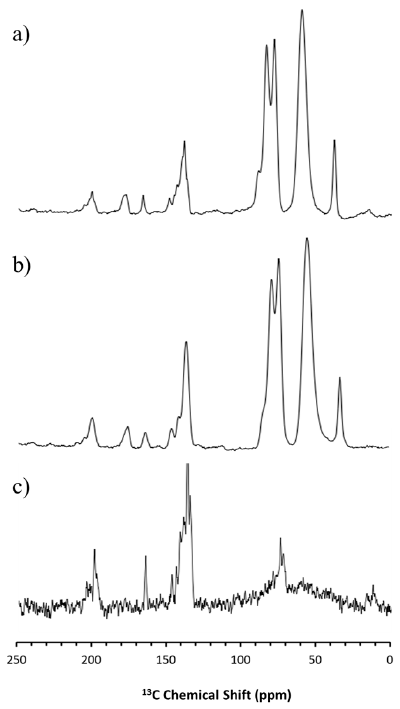
Figure 7. 13 C SS-NMR spectra for crystalline carbamazepine ( c ) and carbamazepine HME formulation at 0 days ( b ) and 90 days ( a ).